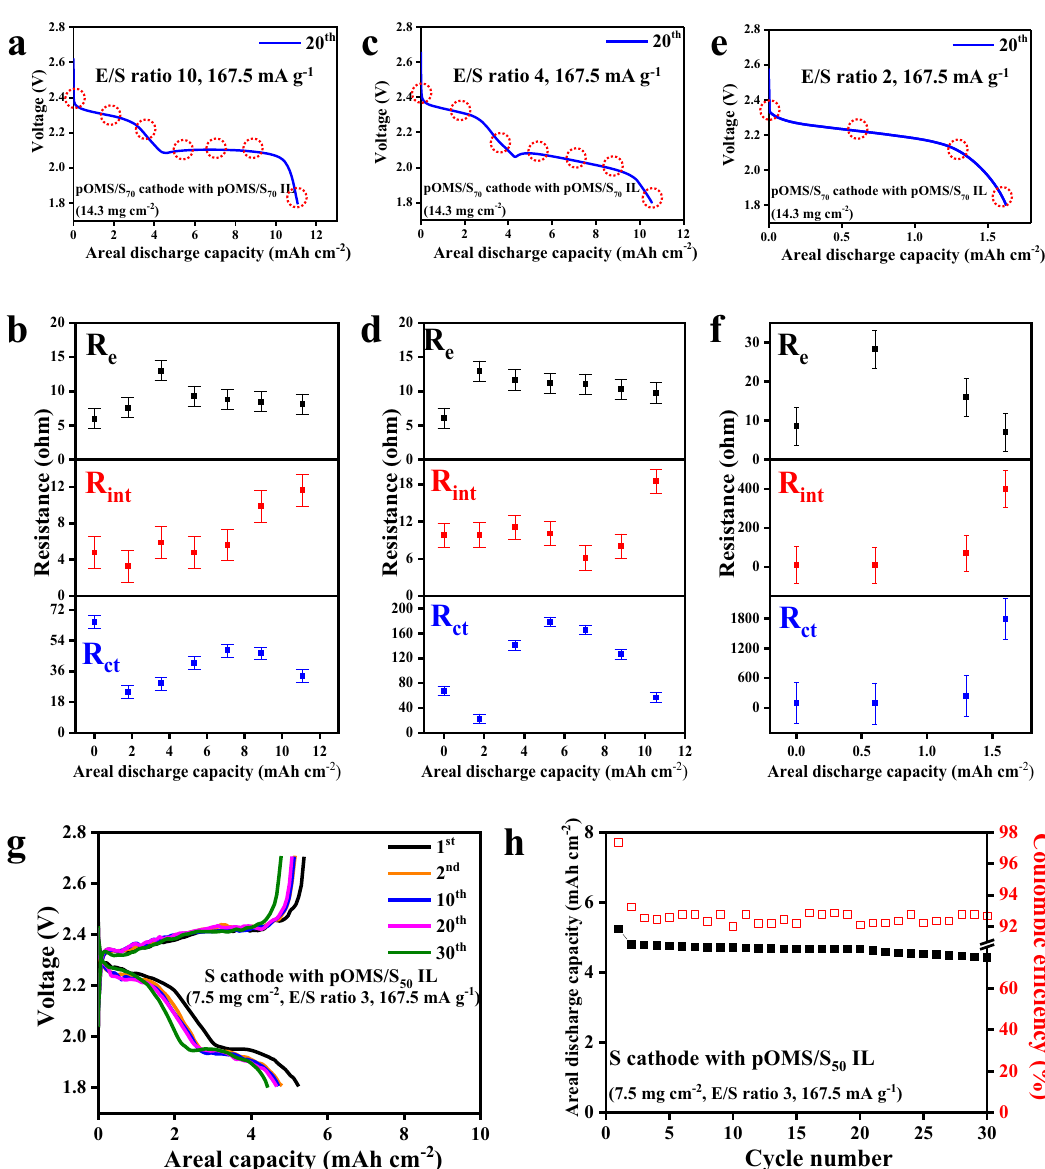
Fig. 5 Electrochemical energy storage performance of Li-S cells at various E/S ratios. The discharge voltage curves and ex situ EIS results of the pOMS/ S 70 cathode with pOMS/S 70 IL at 167.5 mA g − 1 and E/S ratios of ( a , b ) 10 μ L mg − 1 , ( c , d ) 4 μ L mg − 1 , and ( e , f ) 2 μ L mg − 1 . The red dotted circles correspond to the ex-situ point shown in Fig. 5d – f. The displayed error bar is the standard deviation value. ( g ) Charge/discharge voltage pro fi les and ( h ) cycling performance of sulfur cathode with pOMS/S 50 IL at an E/S ratio of 3 μ L mg − 1